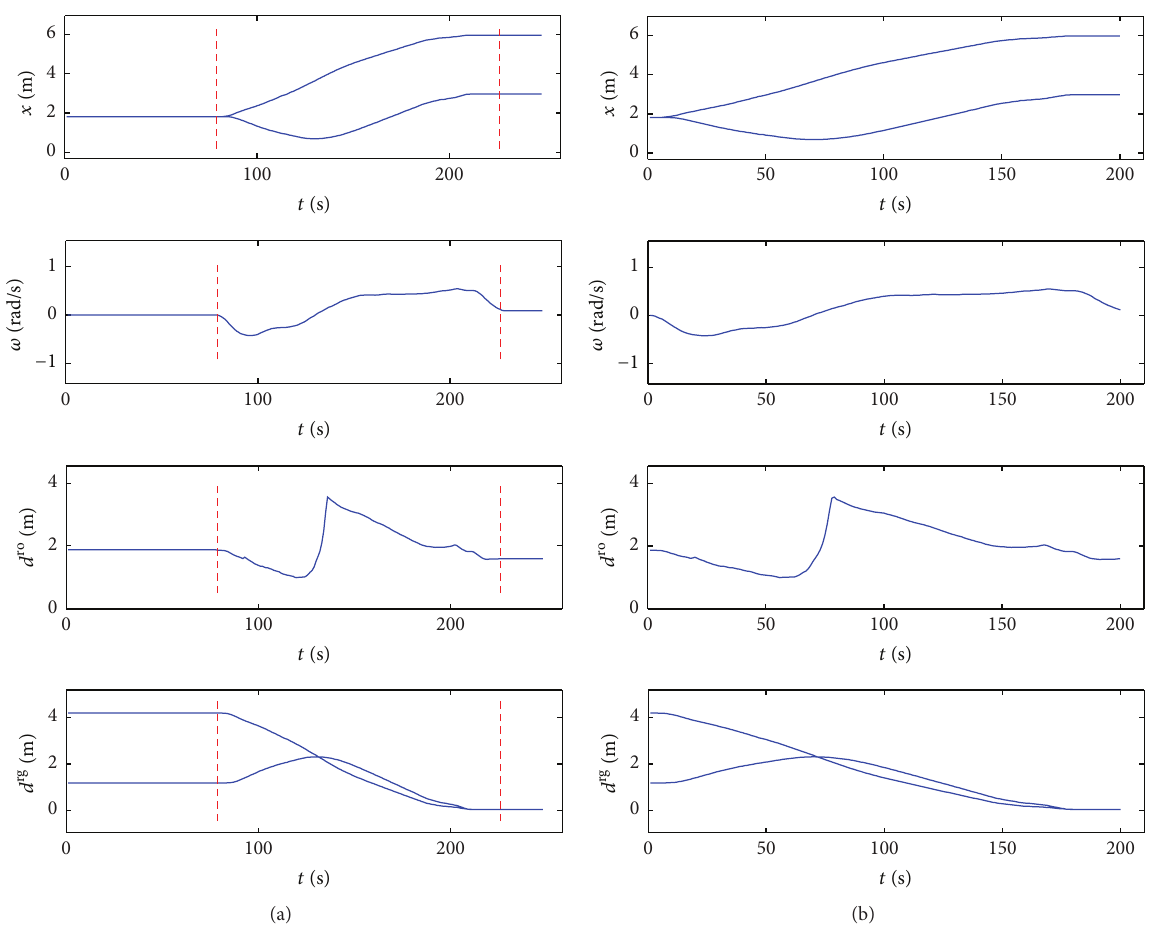
Figure 4: Comparison of original data and processed data. (a) shows the original data. Lines in red represent cutting position. (b) displays valid data after